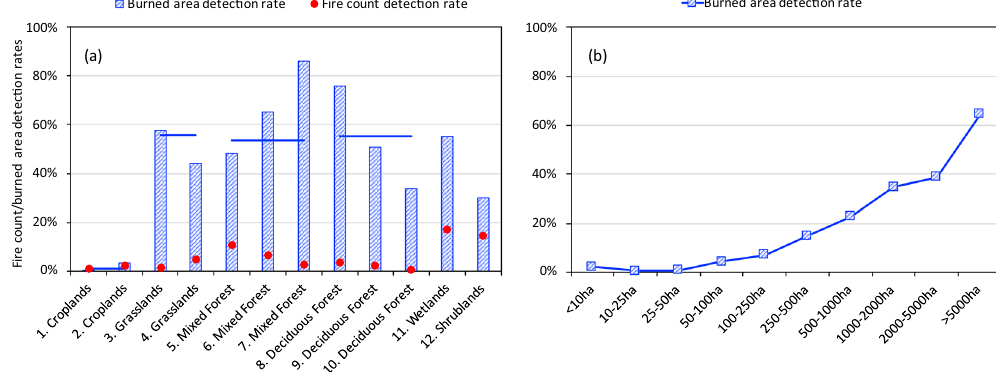
Figure 3. Fire count detection rate and burned area detection rate of MCD64A1 in boreal Eurasia shown as a function of ( a ) vegetation type and ( b ) fire size (only for burned area detection rate). Horizontal bar in ( a ) indicates the average burned area detection rate of the corresponding vegetation